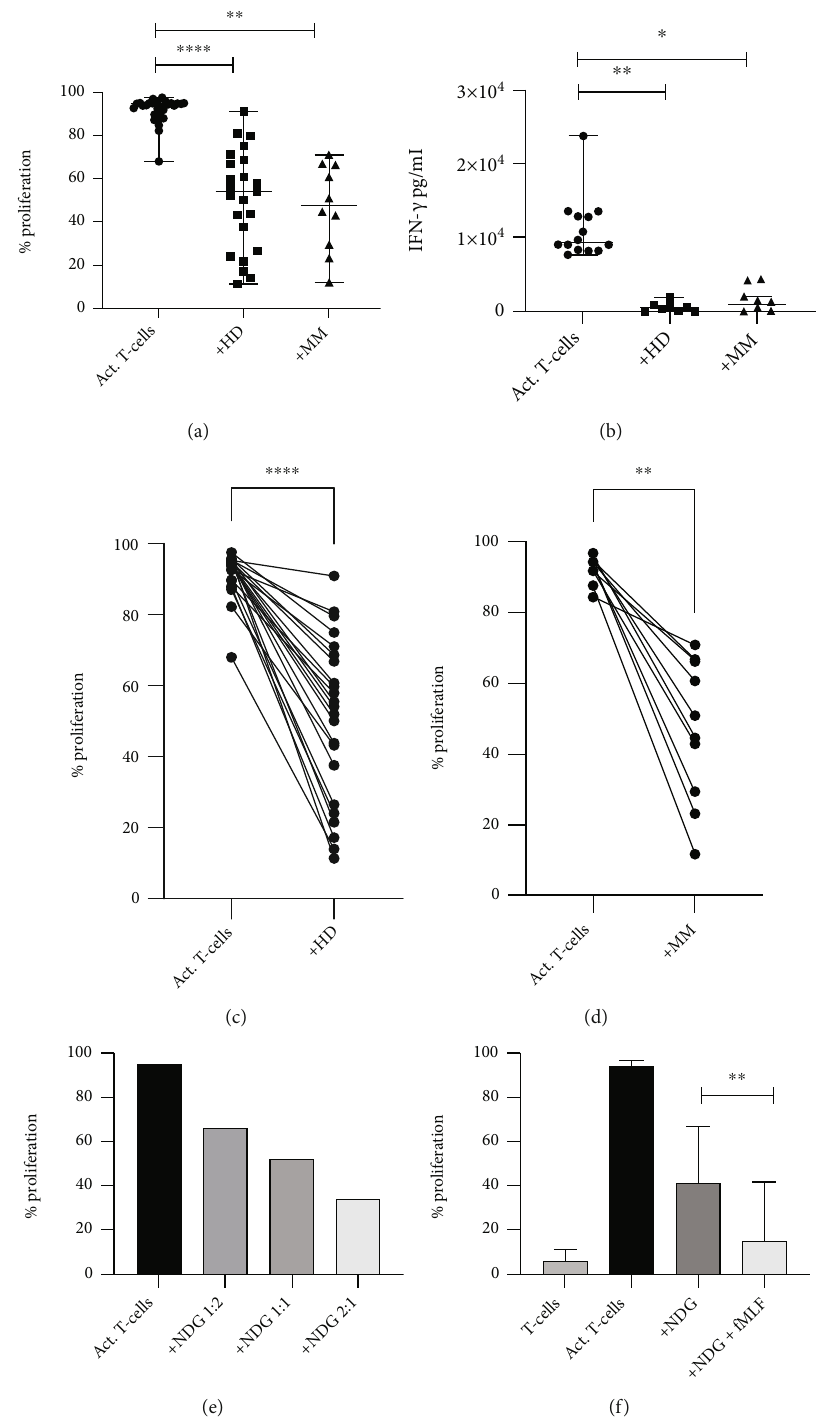
Figure 1: Inhibition of T-cell proliferation and IFN- γ production by peripheral blood normal density granulocytes. (a) Inhibition of proliferation with healthy donor (HD) and MM NDG. HD NDG inhibits T-cell proliferation ( p < 0 : 0001 ), and the median proliferation is 54% (95% CI: 38 – 67). MM NDG also inhibits T-cell proliferation ( p = 0 : 002 ), and the median proliferation is 48% (95% CI: 23 – 67). (b) The median of IFN- γ production for each group is 9400 pg/ml (95% CI: 820 – 13500), 460pg/ml (95% CI: 0 – 1900), and 900pg/ml (95% CI: 0 – 2000), respectively. Both HD NDG ( p = 0 : 0078 ) and MM NDG ( p = 0 : 0312 ) inhibit the production of IFN- γ . (c) The inhibitory e ff ect of HD NDG ( p < 0 : 0001 ) di ff ers between 5 and 84% and (d) between 13 and 75% for MM NDG ( p = 0 : 0156 ). (e) The inhibition of T-cell proliferation by NDG is dose dependent (data from representative experiment). (f) NDGs become more inhibitory in the presence of the activator fMLF ( n = 9 ) ( p = 0 : 0078 ). Error bars indicate median with range. Statistical signi fi cance was tested with Wilcoxon matched pairs signed rank